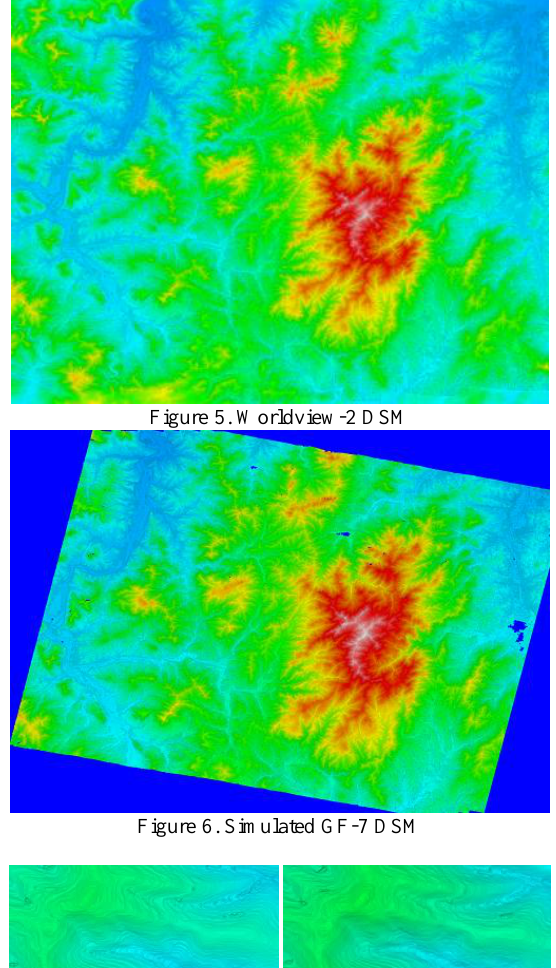
Figure 6. Simulated GF-7 DSM